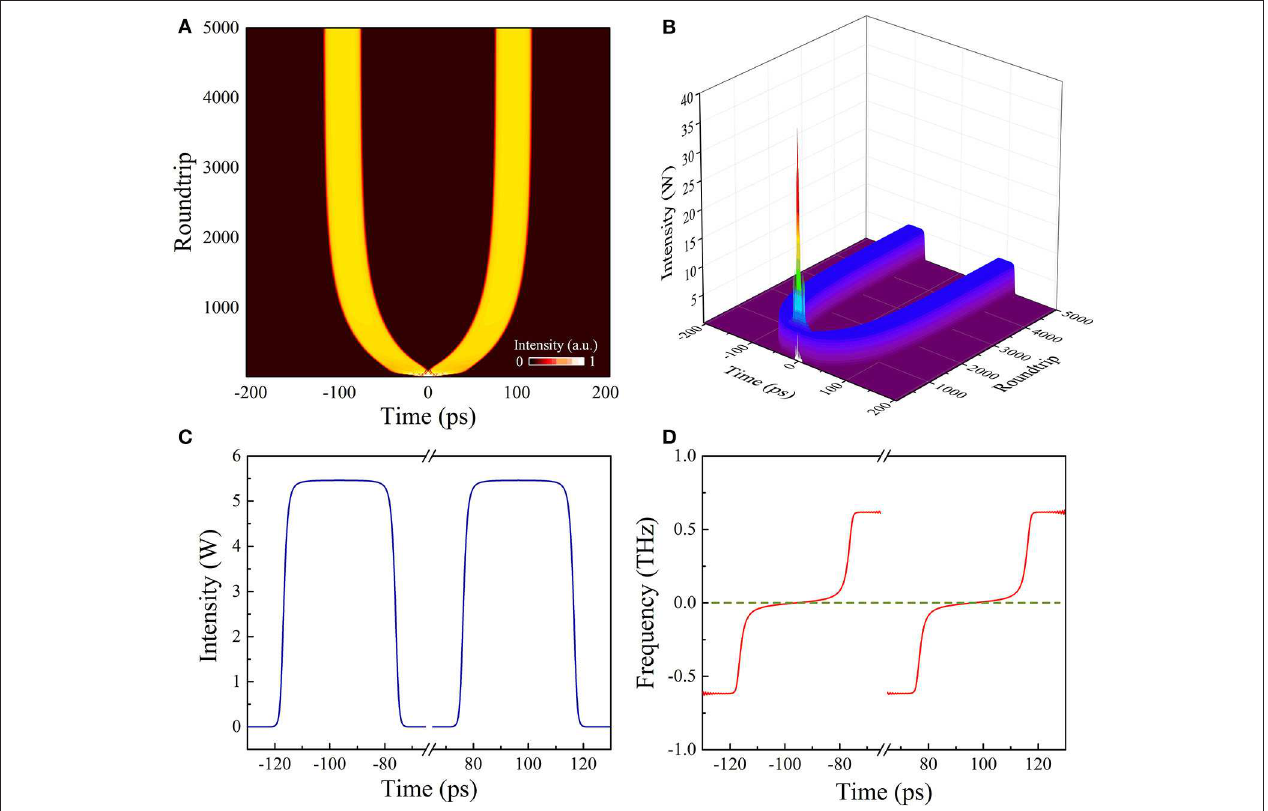
FIGURE 2 | Pulse splitting process of DSR at E sat = 2 nJ. (A) 2D Color fill, (B) 3D color map surface of evolutions. (C) Temporal profiles and (D) instantaneous frequency profiles at N = 5000.